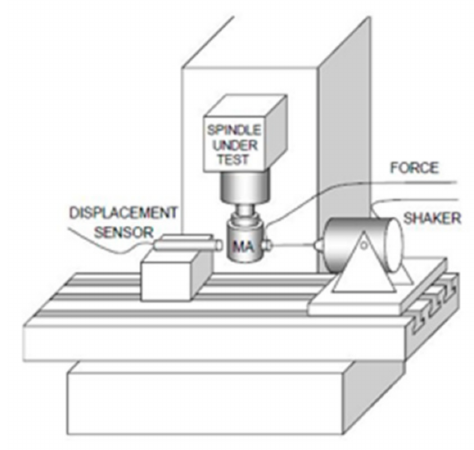
Figure 47. Forcing static and dynamic load [38].